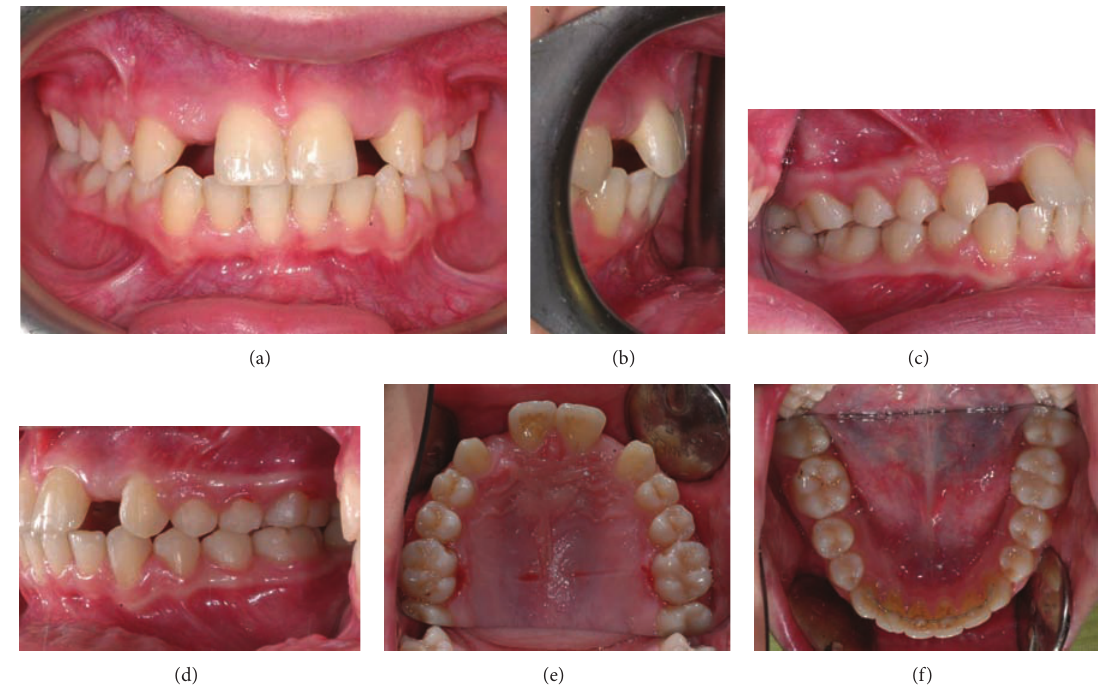
Figure 5: Intraoral photographs after treatment, before implant positioning.